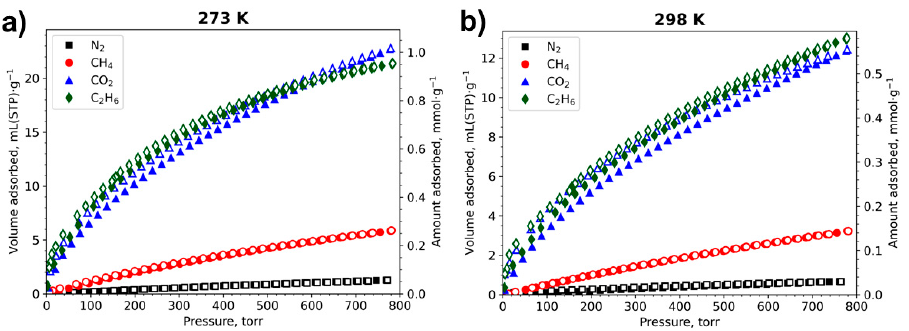
Figure 3. Adsorption and desorption isotherms of N 2 , CH 4 , CO 2 and C 2 H 6 at 273 K ( a ) and 298 K ( b ) for 1a . Table 1. Gas uptakes in 1a at 273 K and 298 K.